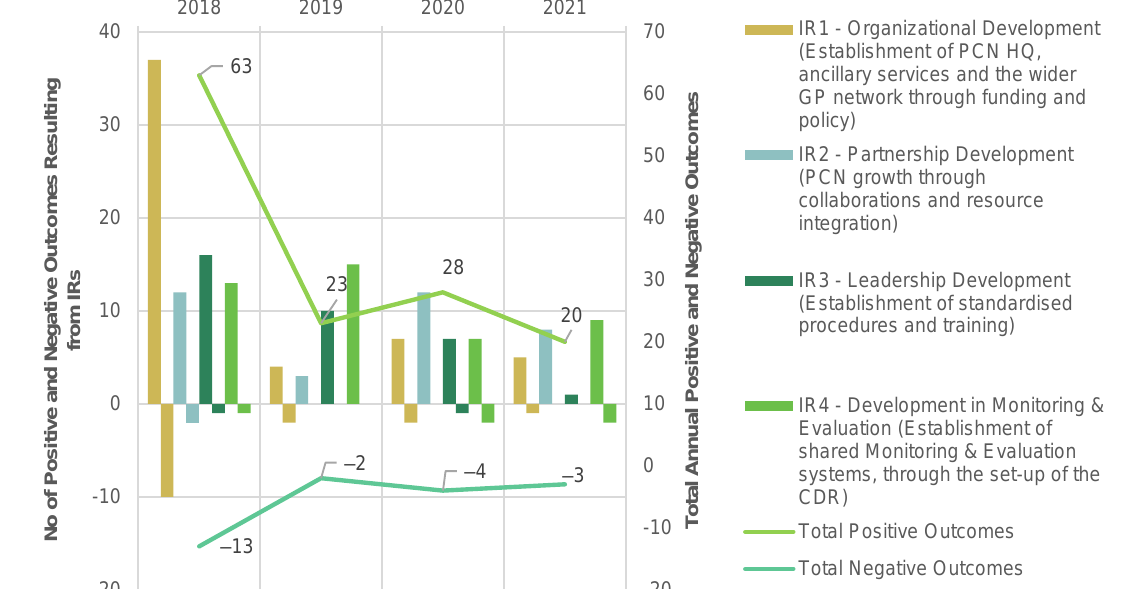
Figure 3. Positive ( N = 134) and negative ( N = 22) outcomes a tied to intermediate results (IRs) over time b . a Summary table of the positive and negative outcomes over time can be viewed in Table A1, in Appendix A. b Some outcomes have been contributed by more than one IRs over time. Hence the sum of all four IR counts per year exceeded the annual total